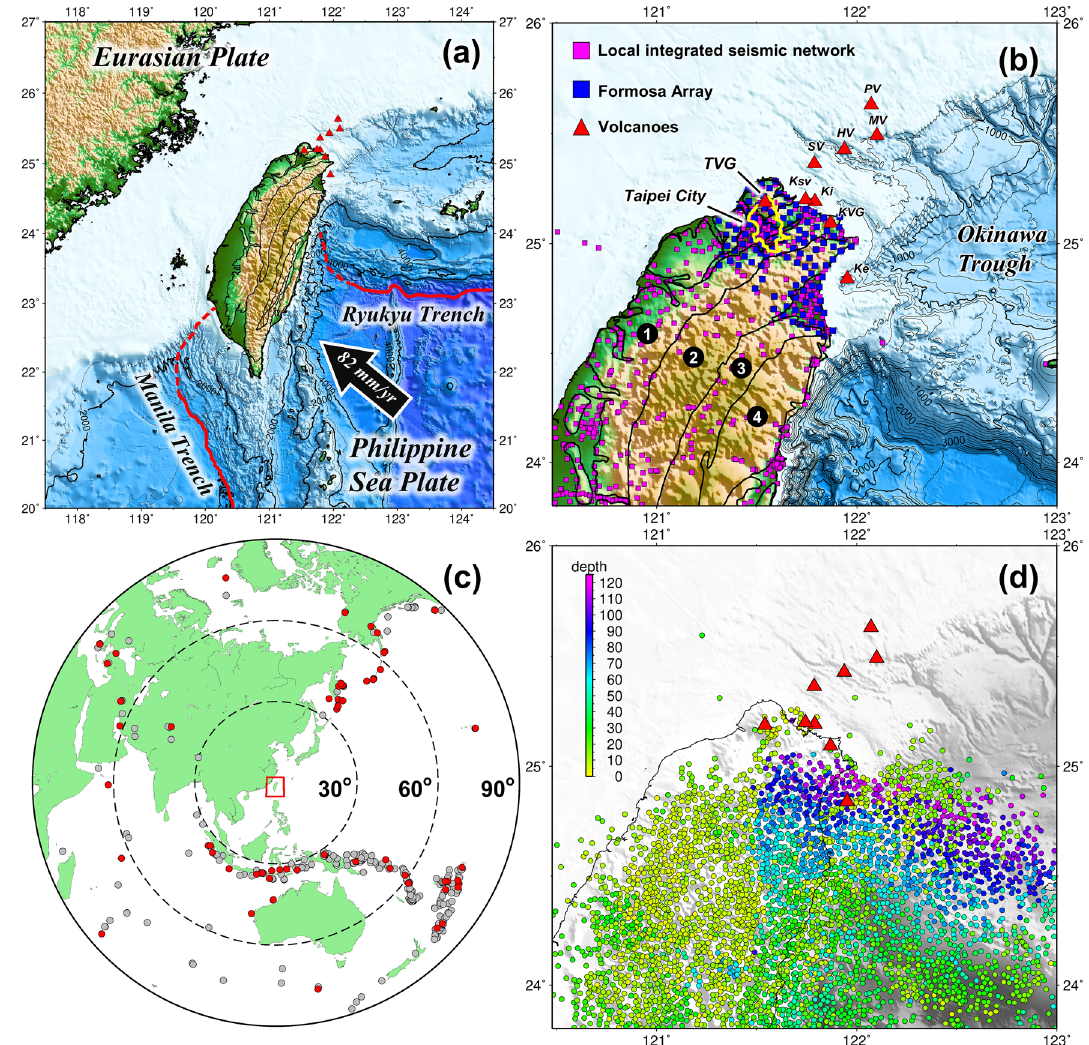
Figure 1. Tectonic and data distribution maps. ( a ) Tectonic setting of the Taiwan region where the Philippine Sea plate subducts northward along the Ryukyu trench and the Eurasian plate subducts eastward along the Manila trench. The black arrow shows the plate motion at 82 mm/year. ( b ) Study area showing the distribution of stations used and regional volcanoes. Purple and blue squares denote the stations of local integrated seismic network and Formosa Array. Red triangles indicate the volcanoes 9 . TVG Tatun volcano group, KVG Keelung volcano group, Ke Kueishantao Island, Ki Keelungyu Island, Ksv Keelung submarine volcano, SV An unnamed submarine volcano, HV Huapingyu island, MV Mienhuayu island, PV Pengchiayu island. Label 1–4 shows geological units of western foothill, Hsuehshan Range, western and eastern Central Range, respectively. Taipei City is outlined by the yellow curves. ( c ) Distribution of teleseismic events recorded (gray dots) and used (red dots) by Formosa Array deployment period. ( d ) Distribution of used local earthquakes color coded by focal depth. This figure is generated by GMT 4.5.18 https ://www.gener ic-mappi ng-tools